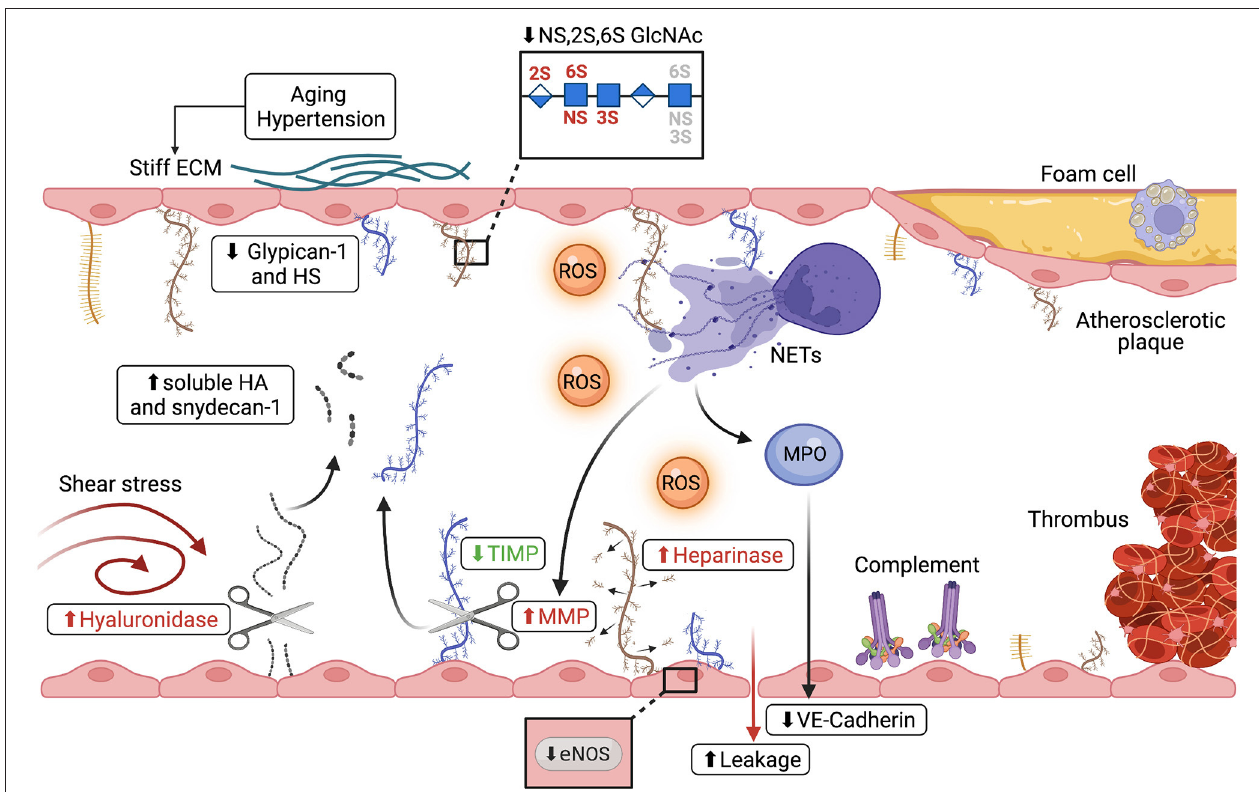
FIGURE 3 | Alterations of the endothelial glycocalyx during thrombo-inflammatory conditions. Different mechanisms lead to shedding of the micro- and macrovascular glycocalyx in atherosclerosis and during ischemia/reperfusion injury (IRI). (I) Disturbed flow increases hyaluronidase expression leading to shedding of hyaluronan (shown in gray) and increased plasma syndecan-1 (shown in blue) and hyaluronic acid. (II) Hypertension, vascular stiffness and aging, all risk factors of cardiovascular disorders, cause thinning of the glycocalyx, evidenced by reduction of both glypican-1 and HS, as well as changes in the sulfation pattern of HS. (III) ROS (shown in orange), advanced glycation end products and sheddases all directly damage the endothelial glycocalyx and are linked to cardiovascular risk factors such as diabetes and obesity. (IV) Disruption of the glycocalyx is shown to be linked to reduced NO production and eNOS activity as well as activation of coagulation pathways and disturbed vasodilation. (V) Both complement deposition on the EC surface and neutrophil activation are associated with glycocalyx damage. Upon activation, neutrophils release neutrophil extracellular traps (NETs), decondensed chromatin decorated with neutrophil proteins. NETs can directly alter the glycocalyx or, through the release of MMPs and MPO (shown in purple), shed glycocalyx components and degrade junction proteins such as VE-Cadherin, leading to increased vascular